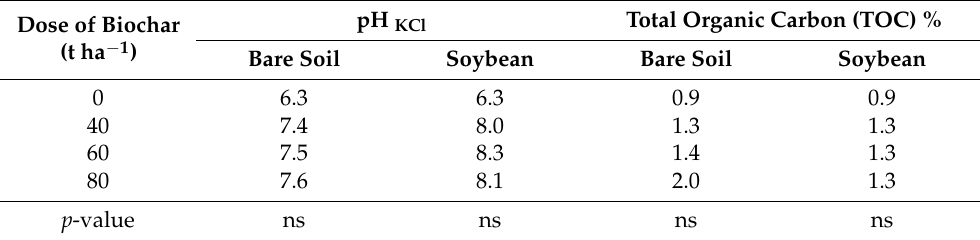
Table 2. Soil pH and total organic carbon (TOC) in soil after the second year from biochar incorporation. Dose of Biochar